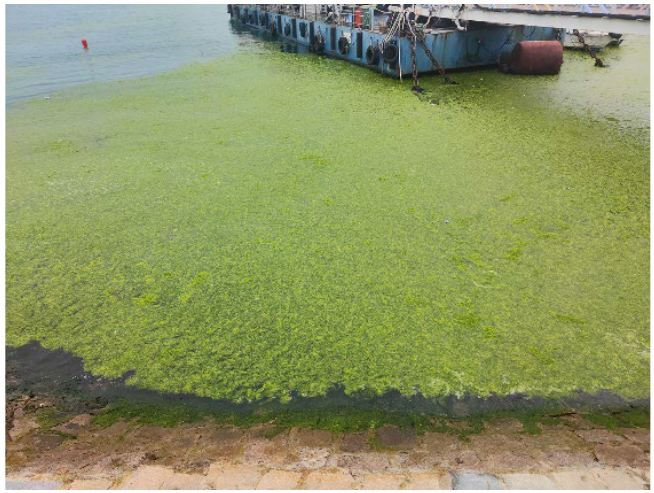
Figure 1. Green tide floating near the coast of Tsingtao on 24 June 2022. There are three main reasons for large-scale green algae blooms in the Yellow Sea.